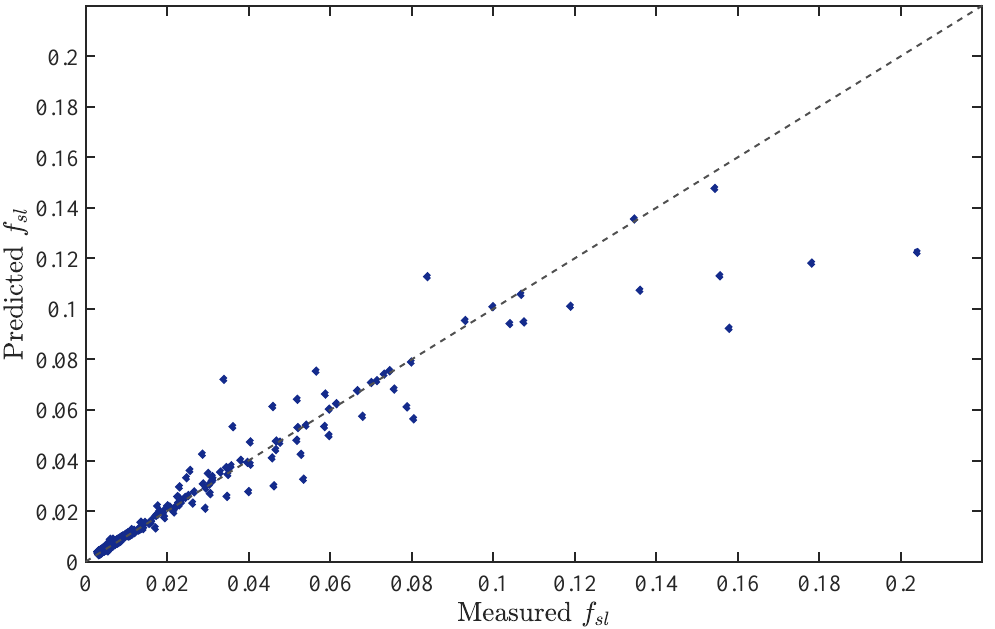
Figure 12. Experimentally measured vs. predicted results of the slurry friction factor for training set with training on SVR without regime classification.